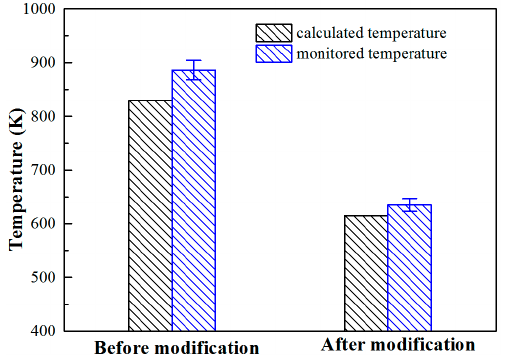
Figure 4. Simulation validation.